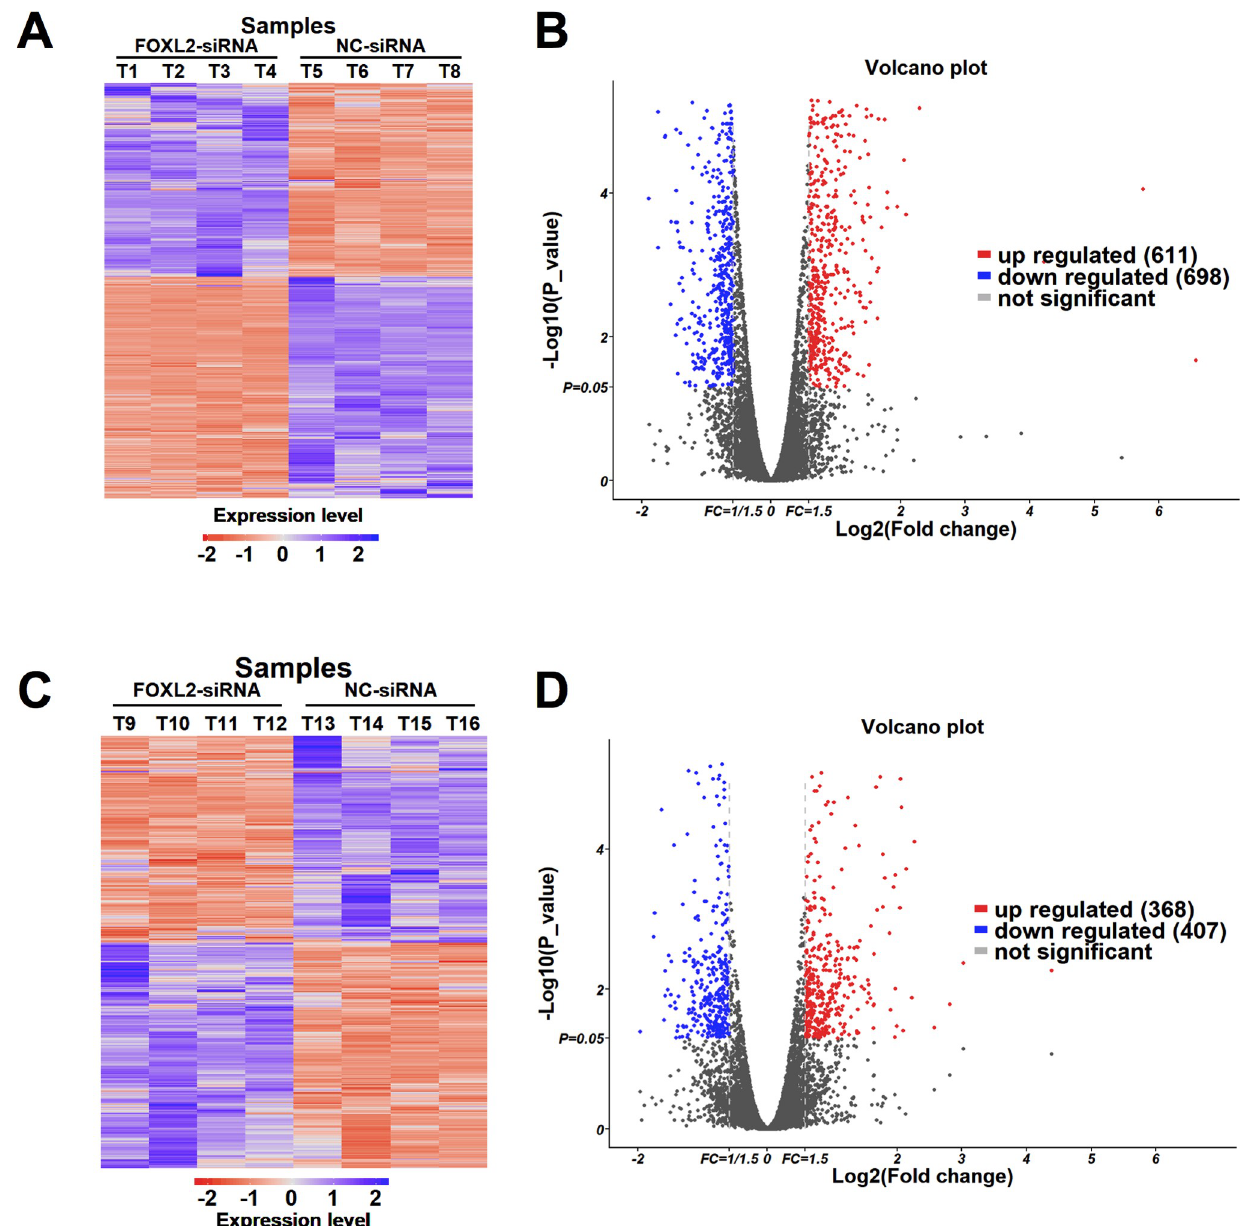
Fig 2. The expression patterns of the DEGs in the chicken granulosa cells induced by FOXL2-siRNA and NC-siRNA. (A) The hierarchical clustering of differentially expressed mRNAs of Comp. po; (B) The Volcano plot of differentially expressed mRNAs of Comp. po; (C) The hierarchical clustering of differentially expressed mRNAs of Comp. ph; (D) The Volcano plot of differentially expressed mRNAs of Comp. ph.